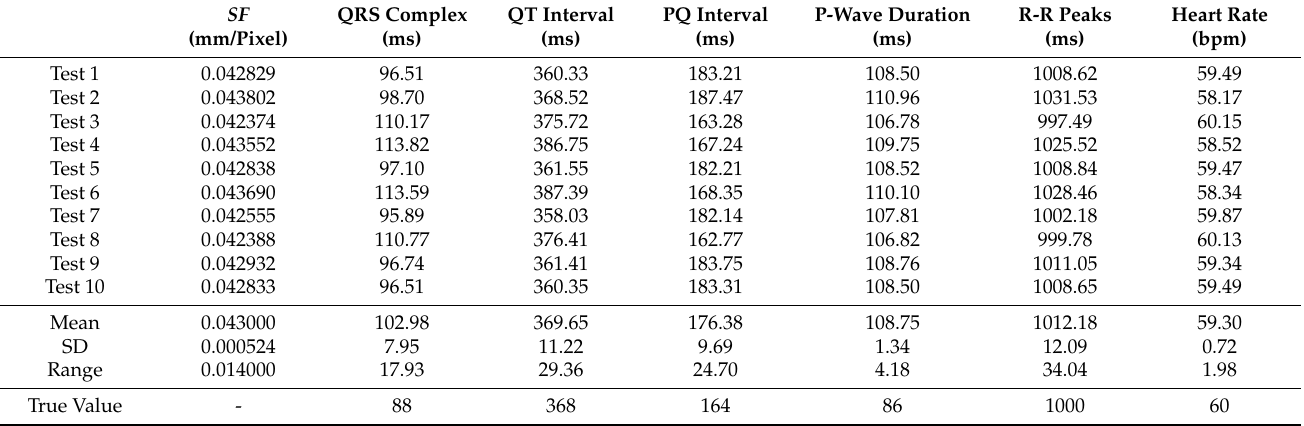
Table 3. Variation of scale factor and time parameters obtained by cropping the same ECG image 10 times (normal sinus rhythm, 60 bpm). The first 10 rows report the values of the ten tests. The 11th, 12th, and 13th show, respectively, the mean, standard deviation (SD), and range of the 10 tests. The last row has the values of the ProSim simulator setting (True